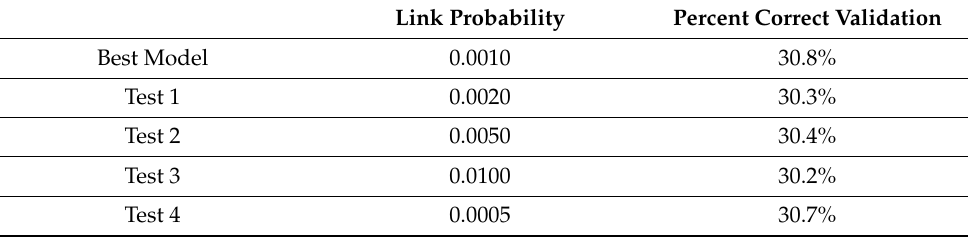
Table 8. Test of different prior link probabilities.